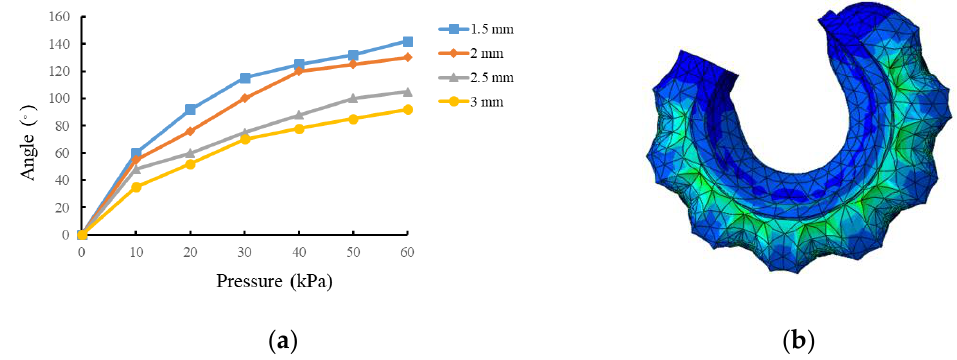
Figure 4. Effect of cavity wall thickness on bending properties. ( a ) Simulation results of different cavity wall thickness; ( b ) BENDING simulation diagram with wall thickness of 1.5 mm at 40 kPa.